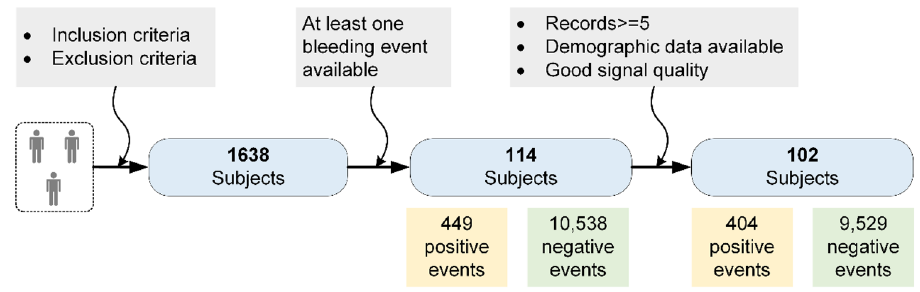
Figure 2. Statistics of subject and record numbers at different